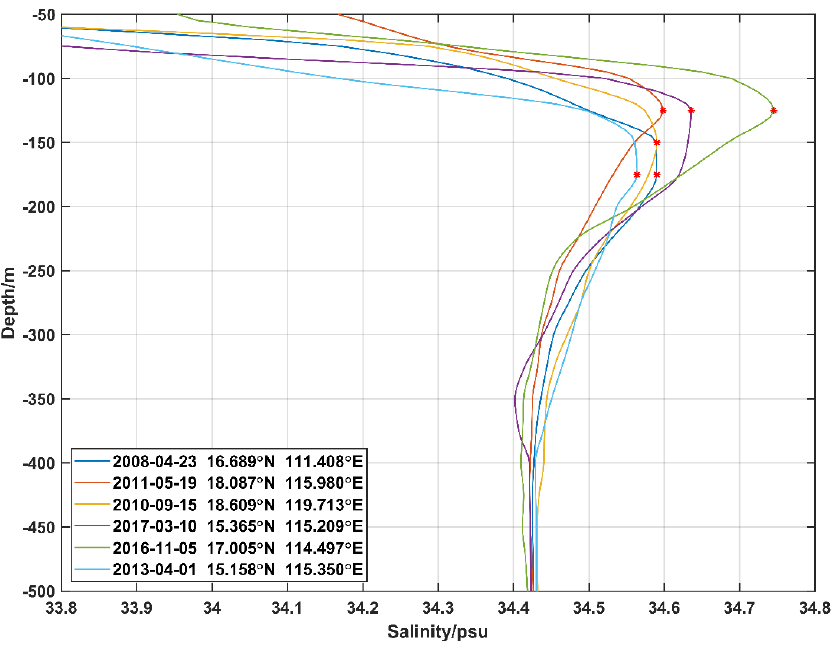
Figure 3. Salinity profiles in the NSCS (red dots are the subsurface salinity maximum).